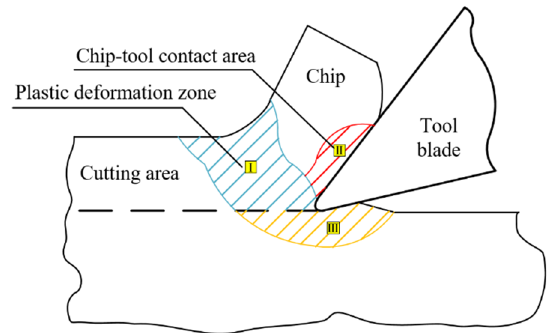
Figure 1. Cutting deformation area of contour bevel gears.